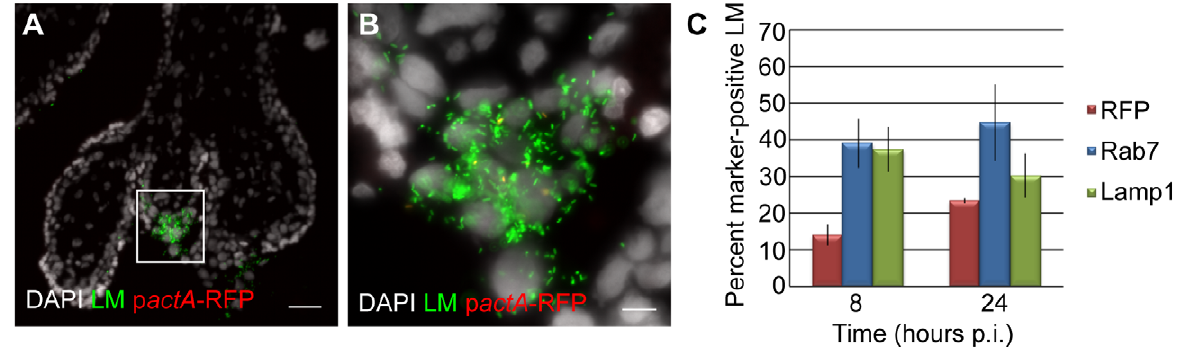
Figure 6. L.monocytogenes (LM) is trapped in late endosomes and lysosomes in EVT of placental explants. ( A ) Representative image of placental explant 8 hours post-inoculation (p.i.) with p actA -RFP LM counterstained with anti-LM antibody (green). DAPI counterstain (white). Scale bar is 50 m m. ( B ) Close-up of boxed area in panel A. Scale bar is 10 m m. ( C ) Vacuolar escape measured by percent RFP expression of p actA -RFP strain counterstained with anti-LM antibody (green). Percent co-localization of LM with late endosomal marker Rab7 and lysosomal marker Lamp1. Each data point is an average of 3 independent experiments. Bars represent SEM.